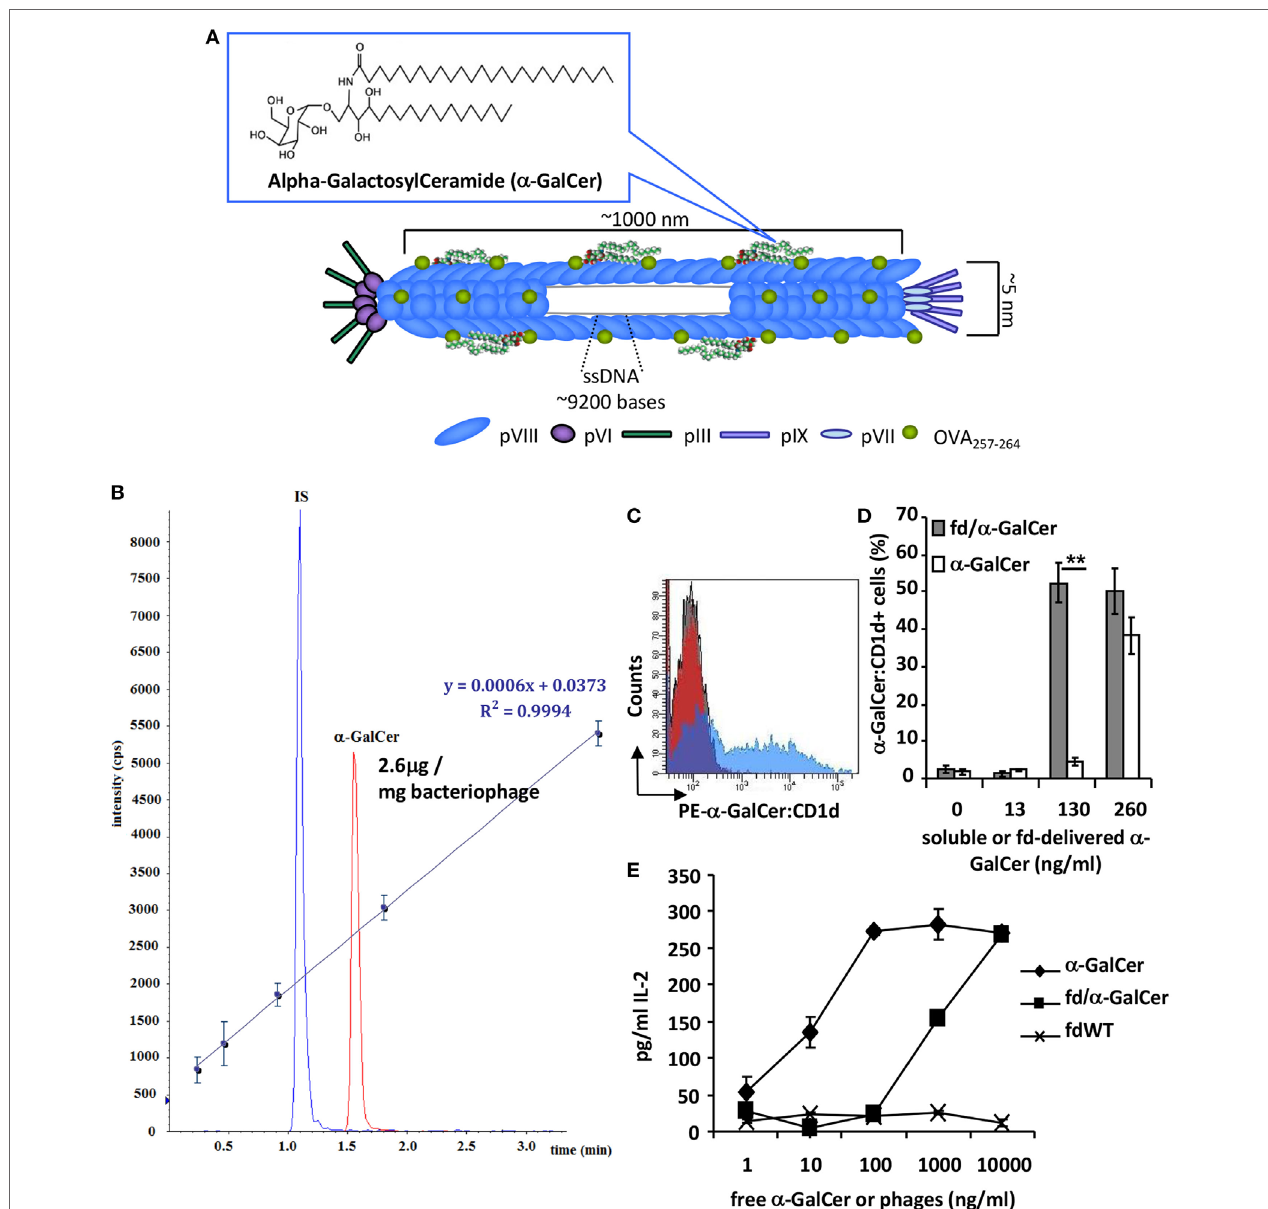
FigUre 1 | fd/alpha-GalactosylCeramide ( α -GalCer) conjugate characterization. (a) Schematic image representing filamentous bacteriophage engineered for the expression of antigenic peptide and α -GalCer on the coat surface. (B) UPLC-multiple reaction monitoring profile of the organic extract of a solution containing 1.5 mg/ml of the bacteriophage conjugated with α -GalCer; IS, internal standard. The calibration curve obtained from five calibration points of α -GalCer STD (62.5, 125, 250, 500, and 1,000 ng/ml) spiked with fixed amount of IS (400 ng/ml) is reported along with equation parameters. (c,D) Dendritic cells (DCs) were cultured with free α -GalCer or fd/ α -GalCer at different doses. After incubation, cells were stained with anti- α -GalCer:CD1d antibody and analyzed by flow cytometry. (c) Representative histogram overlay of DCs incubated with free α -GalCer or fd/ α -GalCer at a dose of 130 ng/ml α -GalCer or fdWT. (D) Percentage of anti- α - GalCer:CD1d positive cells. Mean ± SD of two different experiments is reported. ** p < 0.01 by unpaired two-tailed Student’s t -test. (e) The chart represents the IL-2 release of mouse V α 14 invariant natural killer T (iNKT) hybridoma cell line FF13 to α -GalCer delivered by phage particles. LPS-free filamentous bacteriophages were conjugated to α -GalCer, and presented by mouse DCs to stimulate iNKT hybridoma cells. Free form of α -GalCer was used as positive control. Supernatants were diluted 1:10 and assayed in duplicate. Mean ± SD is reported, one representative experiment of four is